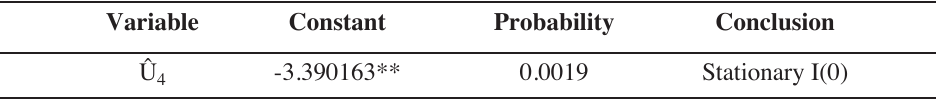
ADF Test for Residuals